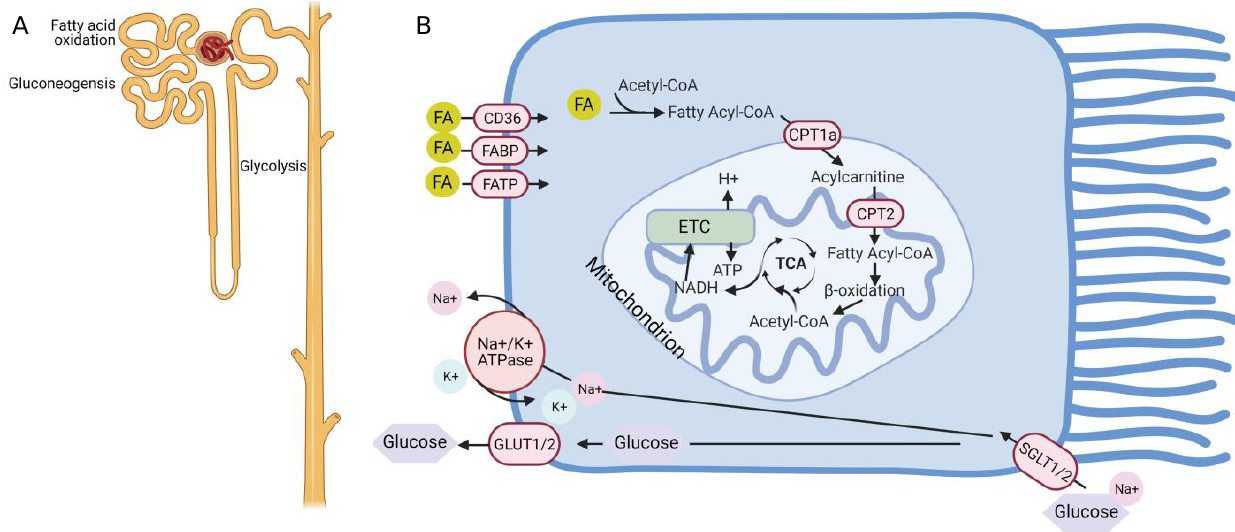
Figure 1. Metabolism in the uninjured nephron and proximal tubule. ( A ) The proximal tubule segment has gluconeogenic capacity and preferentially uses fatty acid oxidation to generate ATP. By contrast, the distal tubules do not have gluconeogenic potential but are better equipped to generate ATP through glycolysis. ( B ) Schematic of metabolism within the proximal tubule showing that glucose is taken up on the apical side by SGLT1/2 transporters and released on the basal side through GLUT1/2. Fatty acids (FA) cross the plasma membrane through CD36, fatty acid binding proteins (FABP), and fatty acid transport proteins (FATP), convert into acetyl-CoA and are transported into the mitochondria through the carnitine shuttle involving the carnitine palmityol-transferases CPT1a and CPT2. Beta oxidation of fatty acyl-CoA produces acetyl-CoA which enters the TCA (tricarboxylic acid) cycle. Oxidation of acetyl-CoA by the TCA produces NADH which enters the electron transport chain (ETC) to generate ATP. Created with BioRen-der.com.